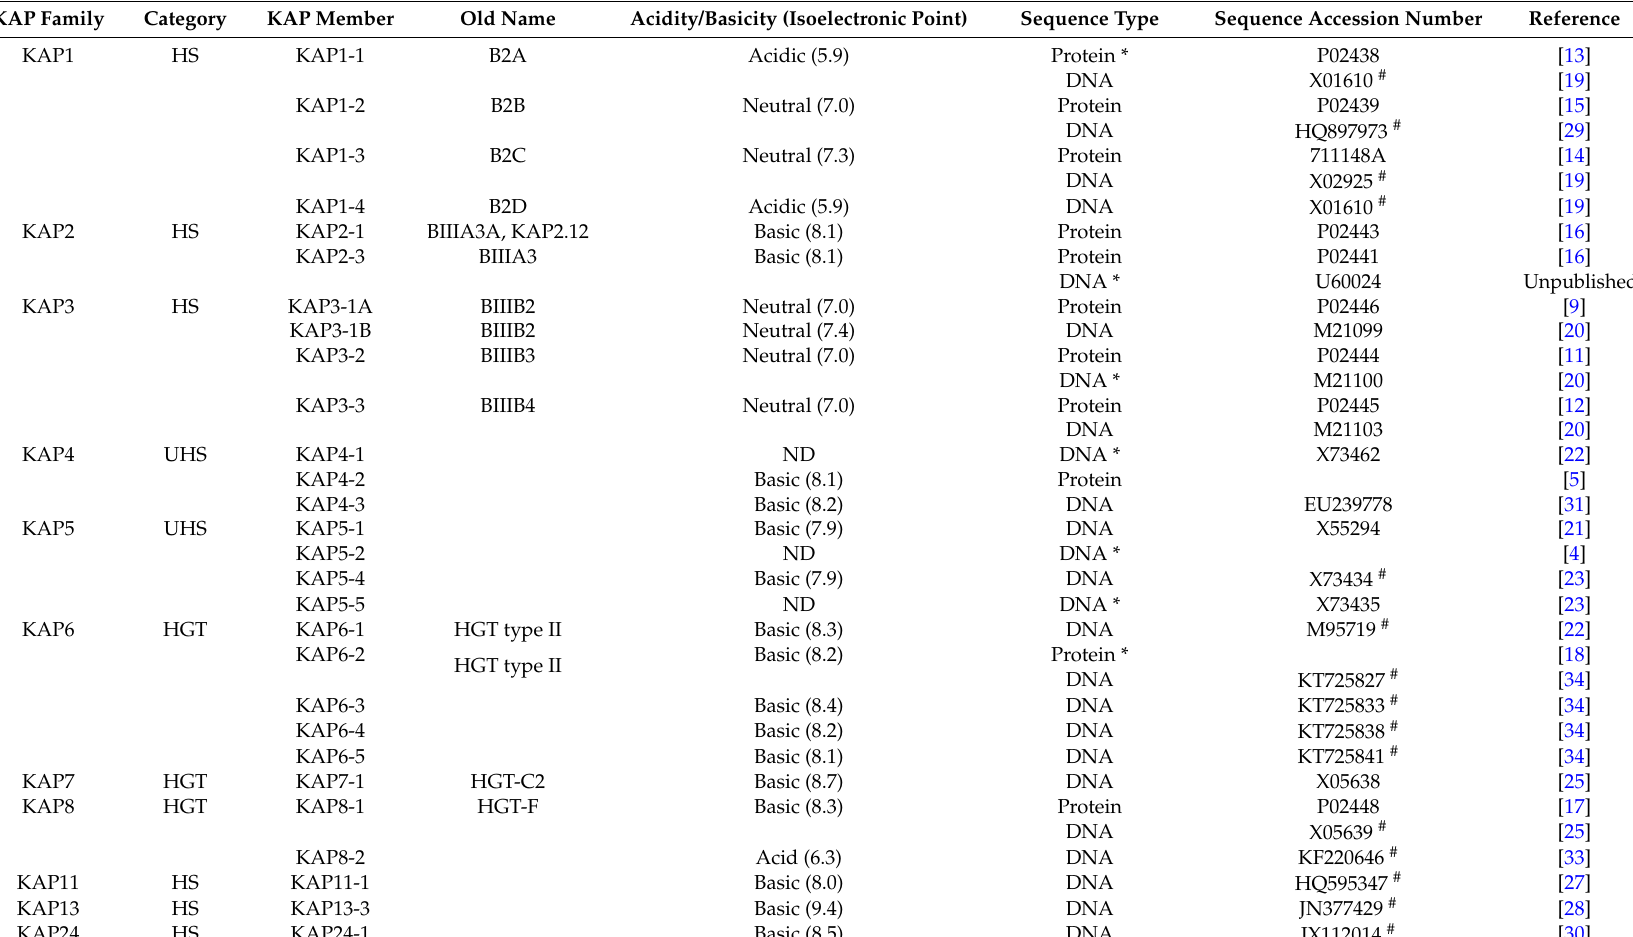
Table 1. Ovine keratin-associated proteins (KAP) protein and gene sequences